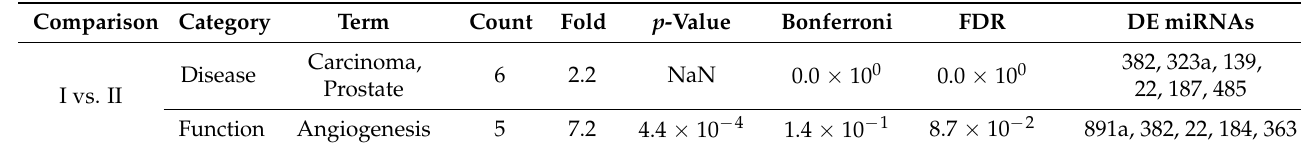
Table 3. Overrepresentation analysis using miRNAs differing between PCa progression groups. Table shows overrepresentation (fold) and miRNAs associating with the disease term “prostate cancer” and the most significant function term(s) (FDR p < 0.05, or p < 0.001, if no terms reached the FDR limit). Bonferroni adjusted p -value is also shown. Differentially expressed